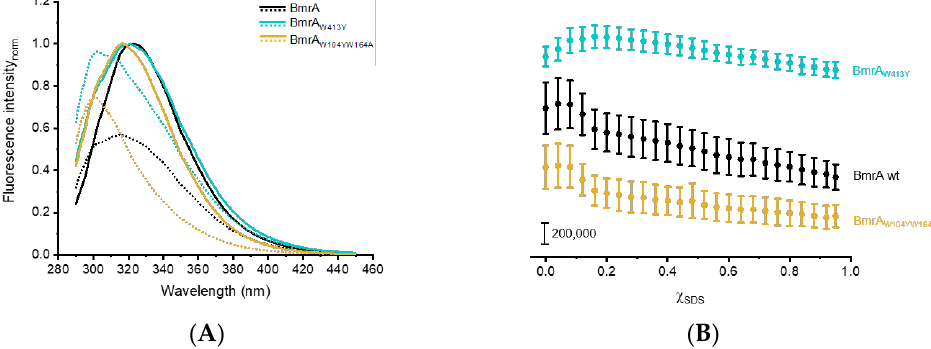
Figure 5. SDS-induced unfolding of the full-length wt BmrA protein and Trp variants. ( A ) Normalized emission spectra of BmrA wt (black), BmrA W413Y (turquoise), and BmrA W104YW164A (ocher). Mean emission spectra of three independent purifications are shown for the native proteins ( χ SDS = 0, lines) and the proteins exposed to the highest SDS mole fraction ( χ SDS = 0.95, dotted lines) (without SD). ( B ) The fluorescence intensities of BmrA wt (black), BmrA W413Y (turquoise), and BmrA W104YW164A (ocher) at increasing χ SDS were determined at a fixed wavelength (BmrA wt: 322 nm; BmrA W413Y : 320 nm; BmrA W104YW164A : 318 nm). Data points represent the means of three independent purifications (±SD). The curves have been shifted vertically for clarity.